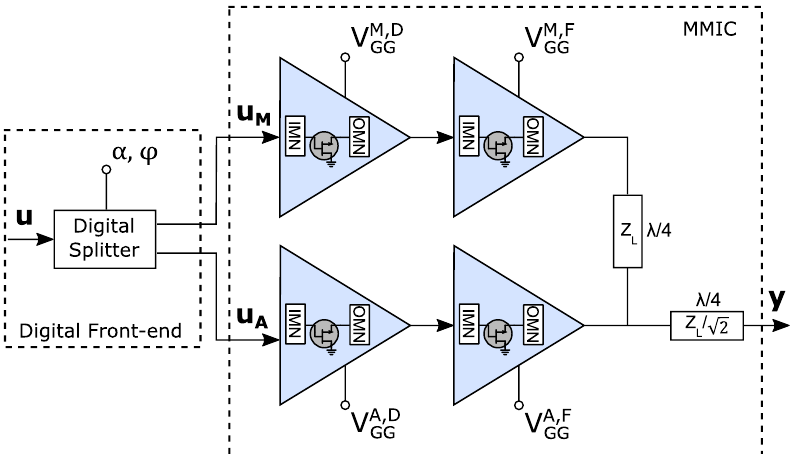
Figure 1. Block diagram of the DIDPA schematic with explicit labeling of the optimization variables ( α , φ , V M , D , V M , F , V A , D , and V A , F ), the main and auxiliary branch RF inputs (respectively, u M and GG GG GG GG u A ), and the RF output ( y ). The block diagram highlights the two-stage DIDPA with the input and output matching networks (IMN and OMN) of each stage, and the quarter-wave output combiner.